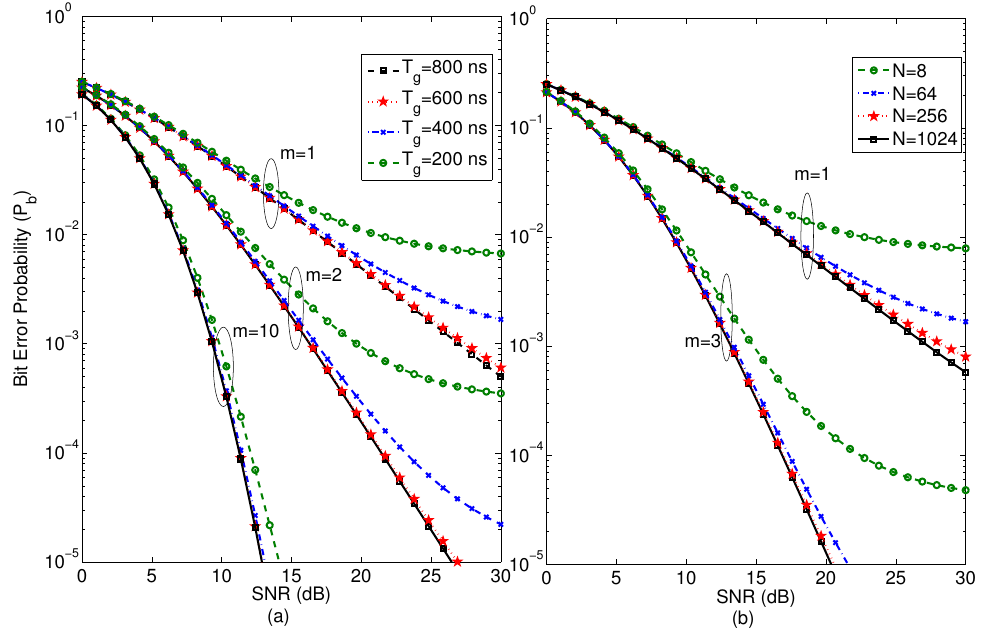
Figure 4. OFDM–BDPSK system with ( a ) N = 64 and different guard period durations and severity parameter ( m ) values ( b ) T g = 400 ns and BW = 20 MHz with different numbers of subcarriers and severity parameter ( m )